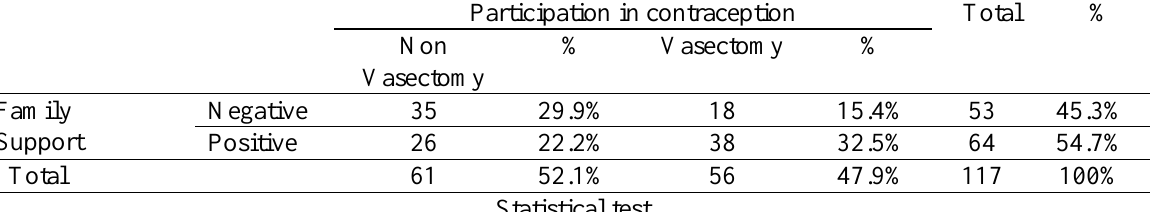
Table 8 The correlation of family support with vasectomy